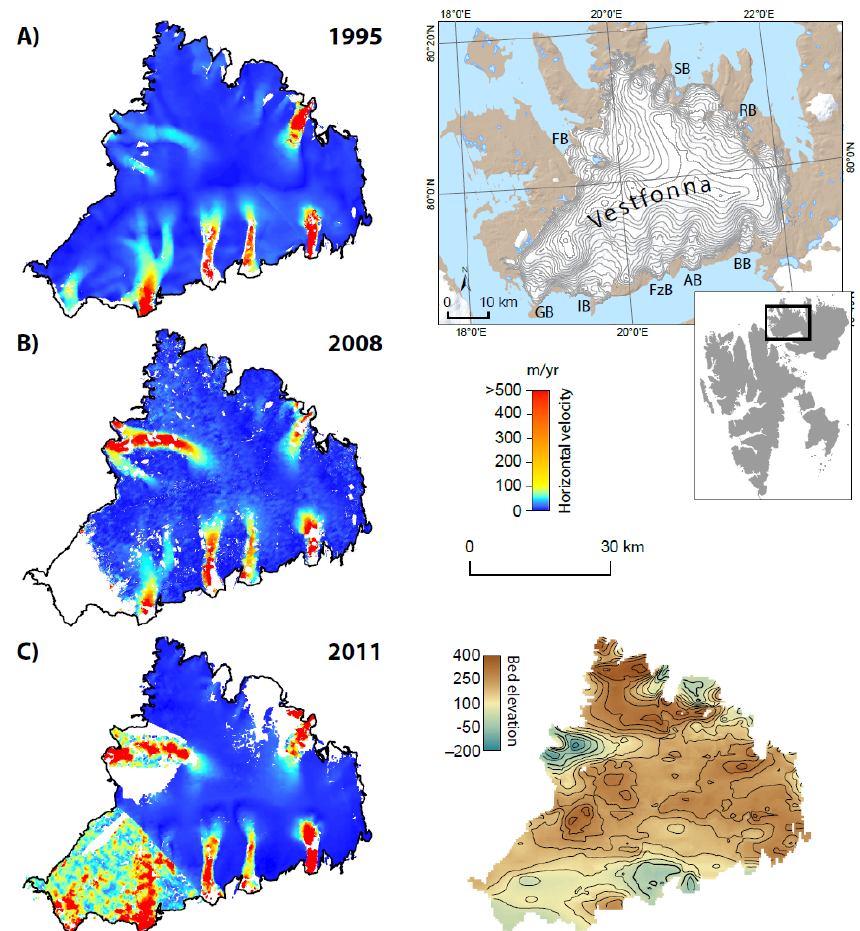
Figure 1. Surface velocities from remote sensing data in December/January 1995/96, December 2008 and December 2011 (original data, left side). To the right, the location of the ice cap in Svalbard (middle), surface (top) and bedrock topography (bottom) are illustrated. Sea level is indicated by a bold line. FB indicates the location of Franklinbreen, SB Sabinenbreen, RB Rijpbreen, BB Bodleybreen, AB Aldousbreen, FzB Frazerbreen, IB Idunbreen and GB